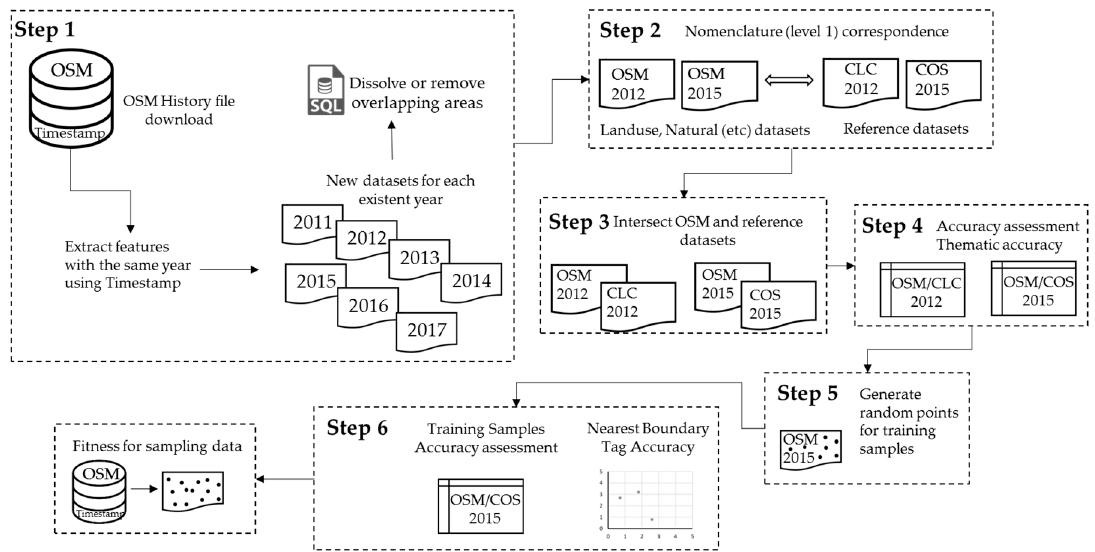
Figure 2. Workflow representing the proposed methodology.